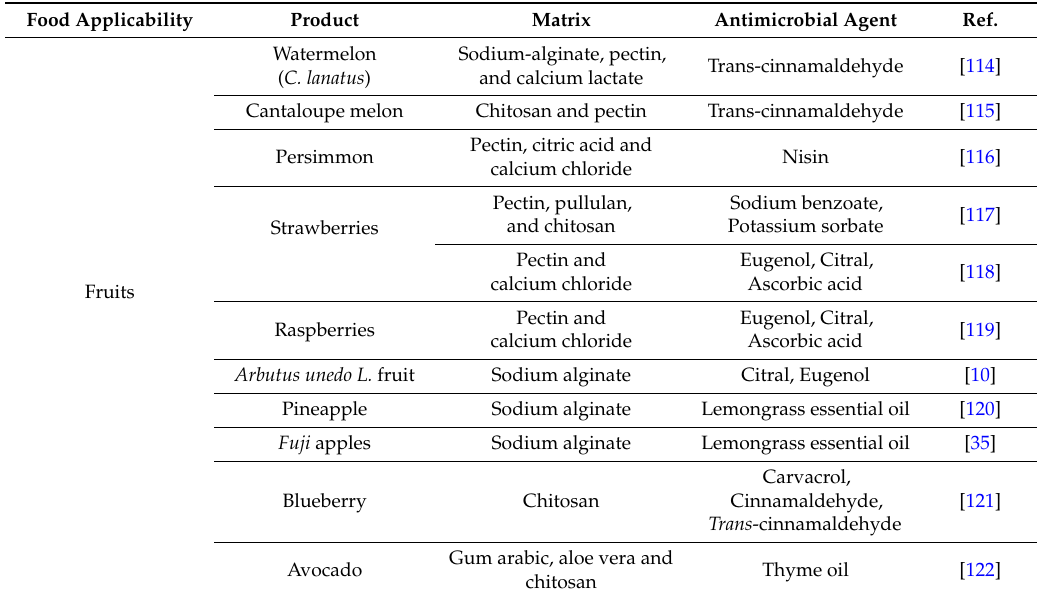
Table 3. Antimicrobial coatings developed for fruits and